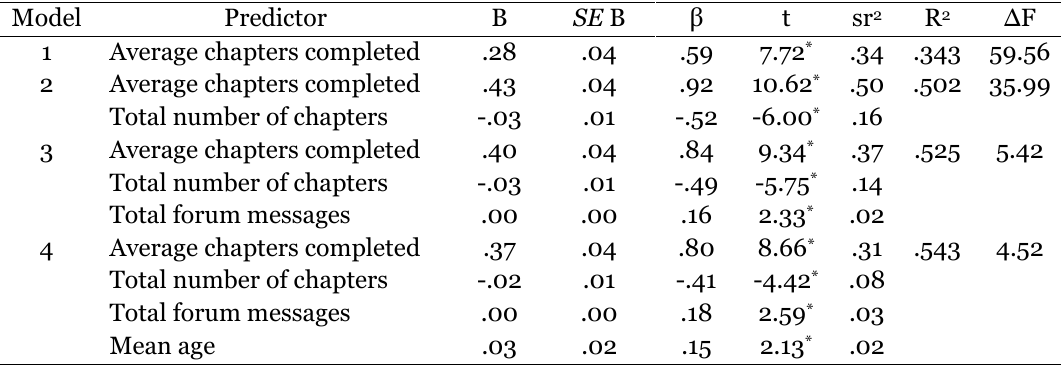
Stepwise Multiple Linear Regression